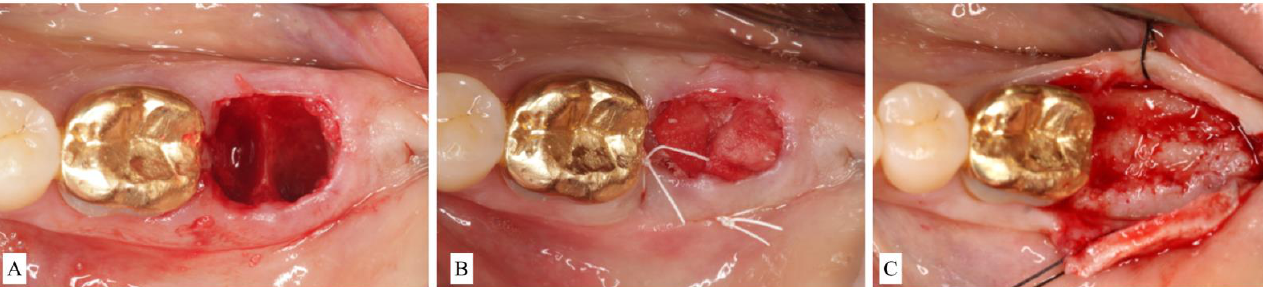
Figure 3 . ( A ): Clinical view of alveolar socket after extraction of a second molar. The buccal bone was preserved in height but thinner than 1.0 mm. The case was classified as Socket type 1B (ST1B). ( B ): The socket was filled with particulate bone-grating material and coronally sealed with a colla- gen plug. ( C ): Surgical re-entry at the time of implant placement showed successful ridge preserva-